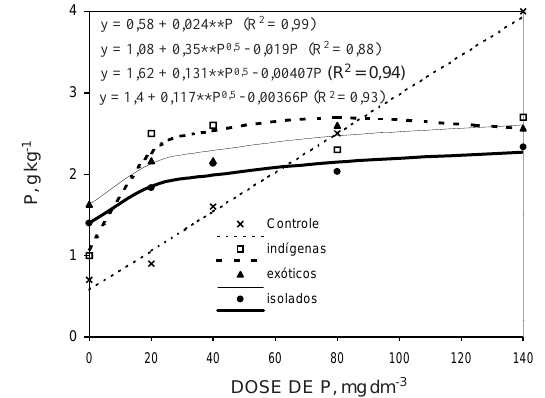
Figura 2. Teores de fósforo na parte aérea de plantas de mamoiero inoculadas com diferentes fungos micorrízicos, exóticos ou isolados nativos, em solo com doses crescentes de P. (** Coeficientes significativos a